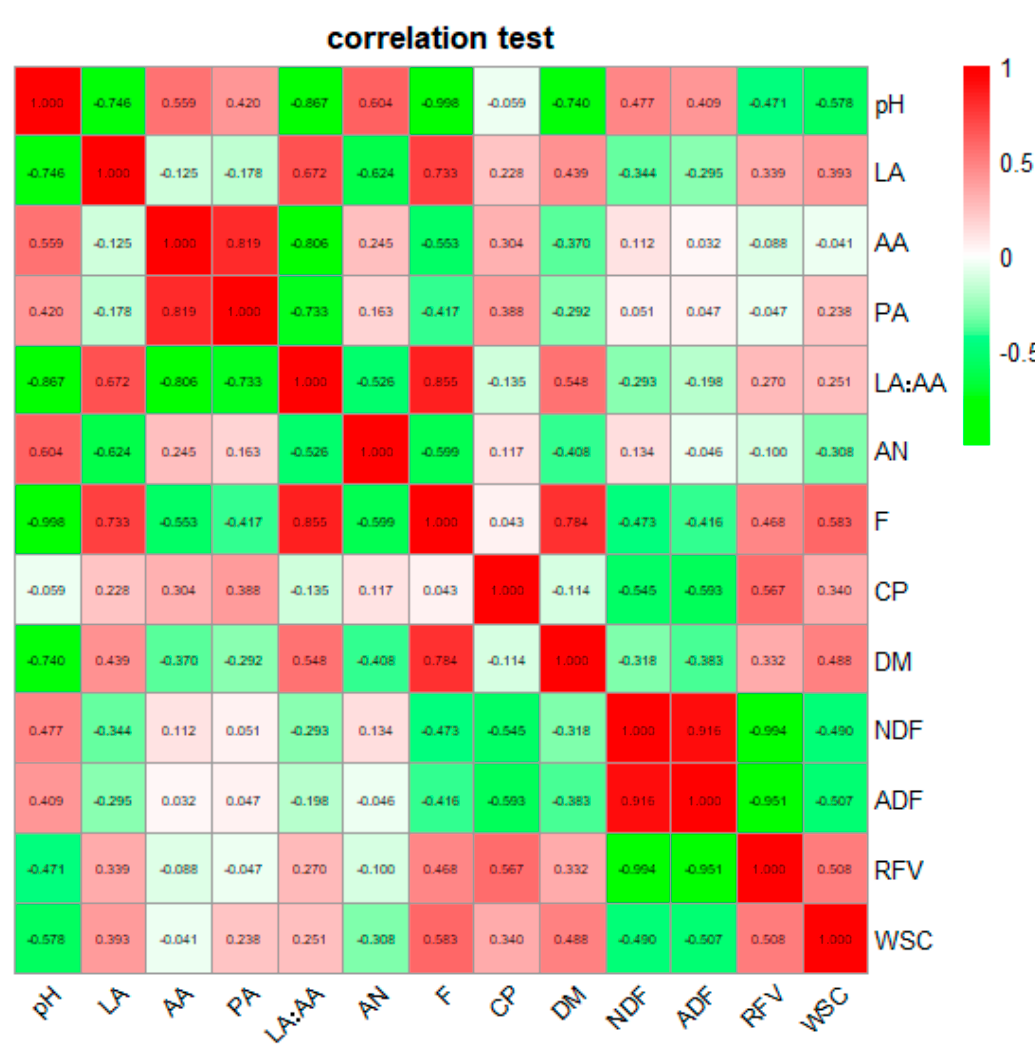
Figure 7. Pearson correlation between the fermentation and chemical indexes of alfalfa silages at 30 d of ensiling. LA, lactic acid; AA, acetic acid; PA, propionic acid; LA:AA, lactic acid: acetic acid ratio; AN, ammonia nitrogen; F, Fleig’s point; CP, crude protein; DM, dry matter; NDF, neutral detergent fiber; ADF, acid detergent fiber; RFV, relative feed value; WSC, water-soluble carbohydrates. The number in each square represents the correlation extent; the color represents significant correlation ( p < 0.05), the deeper the color of the square is, the more significant the correlation. The red color means a positive correlation, and the green color means a negative correlation.